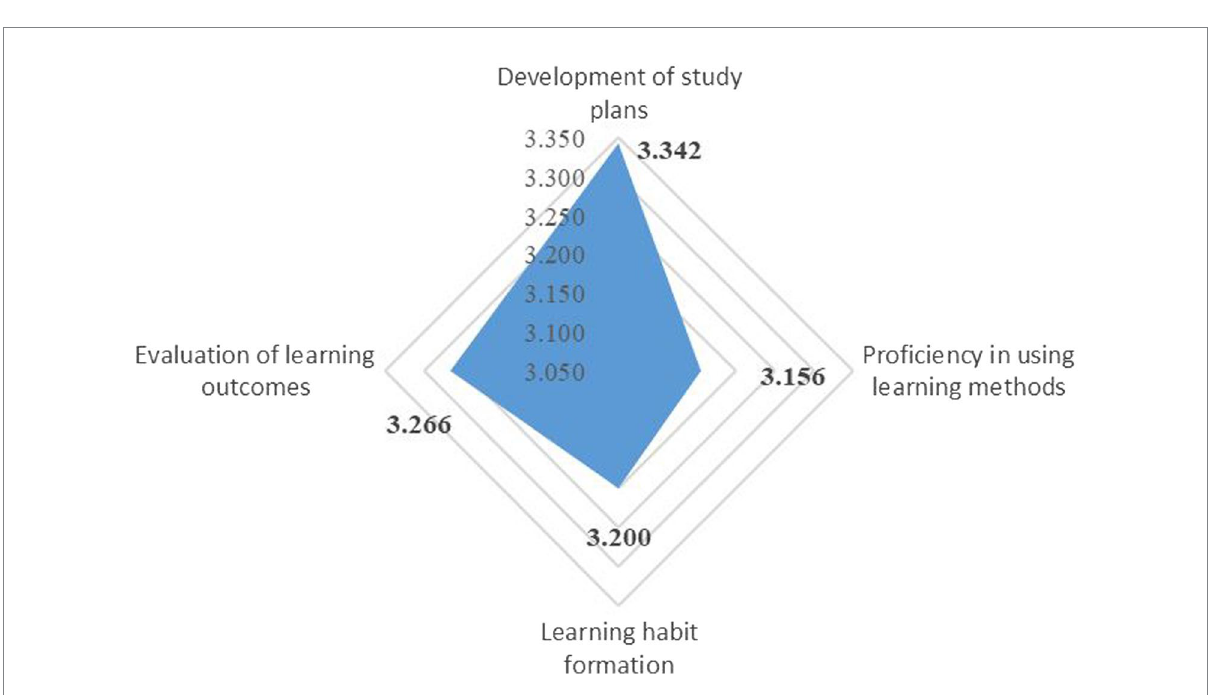
FIGURE 1 Subdimension means of teachers’ autonomous learning